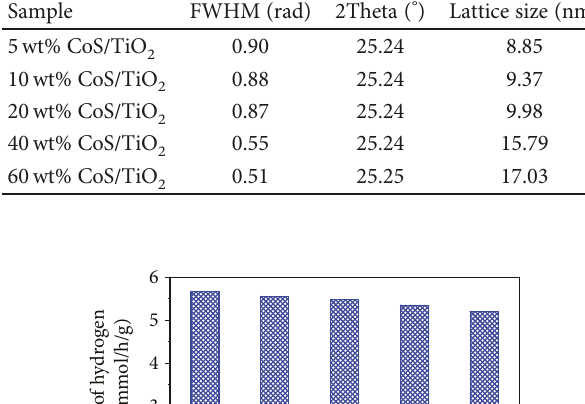
, (c) SEM image of 60wt% CoS/TiO 2 Table 1: Lattice size of CoS/TiO